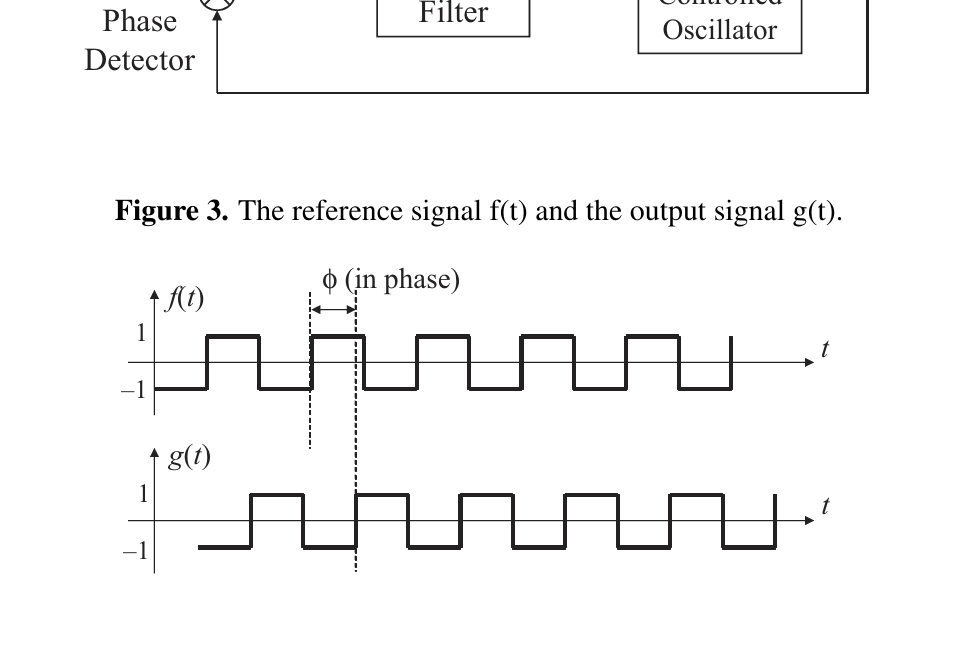
Figure 4. The relation between the time correlation and the phase